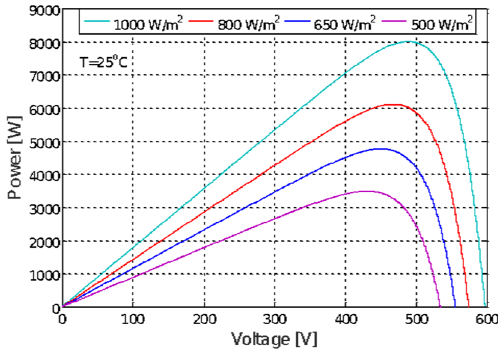
Figure 2. An 8 kW PV array: power output for different irradiation levels.